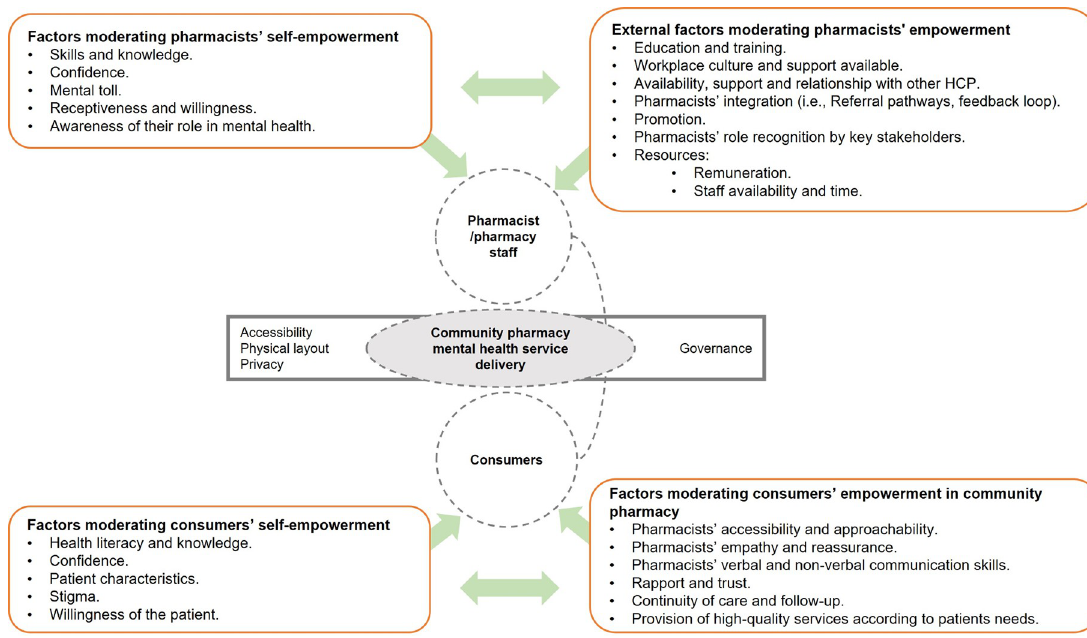
Fig 2. Framework presented to participants for validation in follow-up focus groups.